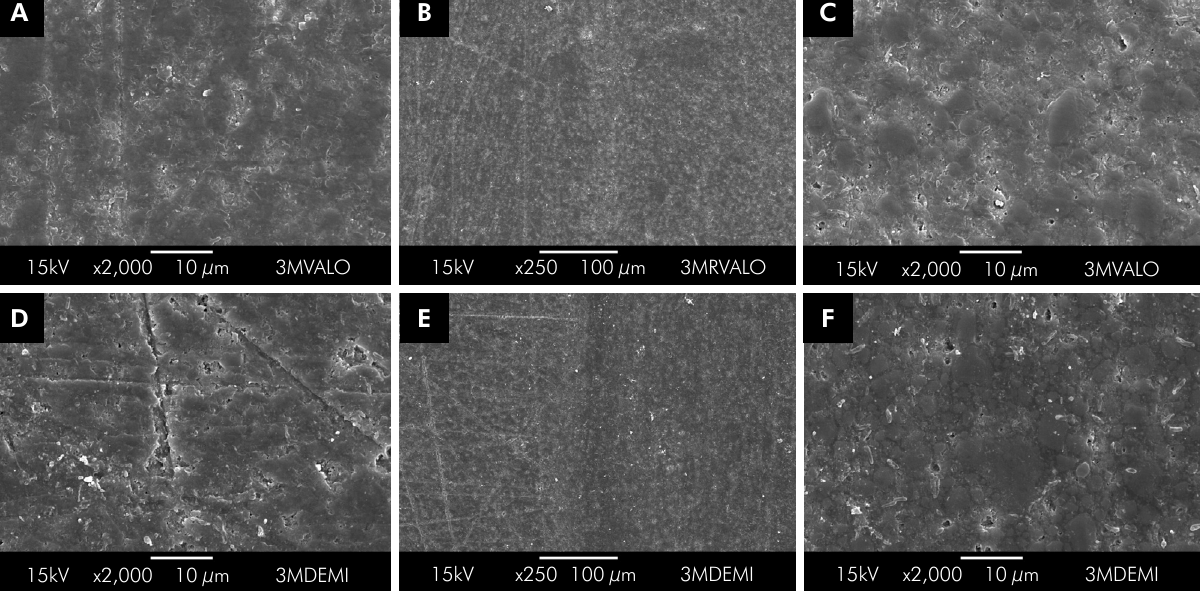
Figure 3. SEM images (250 x and 2000 x) showing the surfaces (unbrushed/control and brushed sides) of FBF. A- unbrushed area, B- border area between unbrushed control and brushed sides and C- brushed area polymerized with Valo. D- unbrushed area, E- border area between unbrushed control and brushed sides, and F- brushed area polymerized with Demi